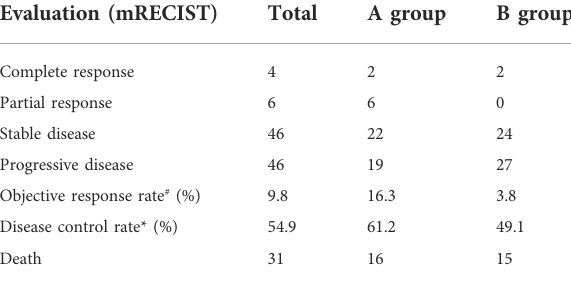
TABLE 4 Treatment response of